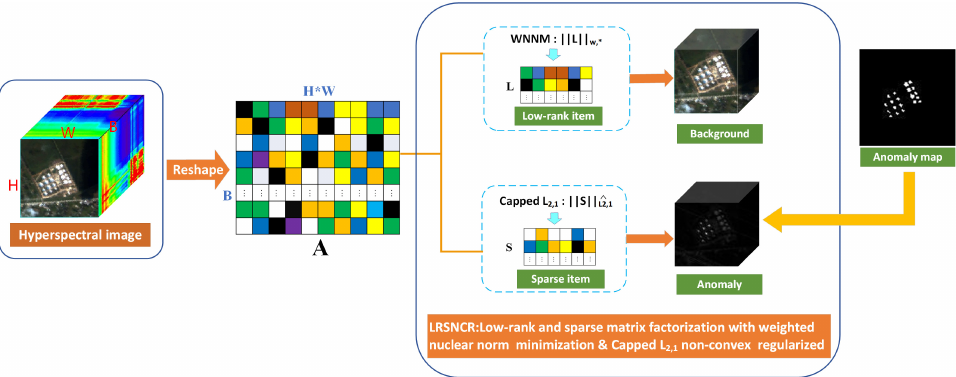
Figure 3. Flowchart of anomaly detection based on